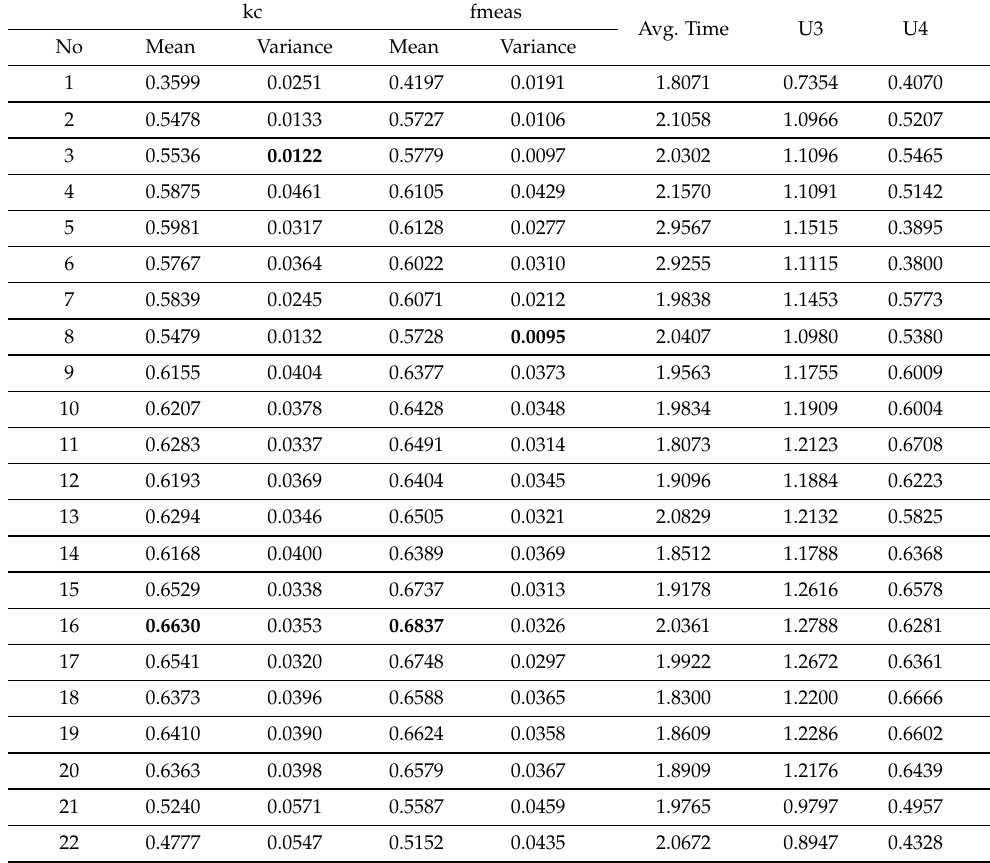
Table 6. Utility Values Based on Overall Accuracy Results and Average Computing Times for Each